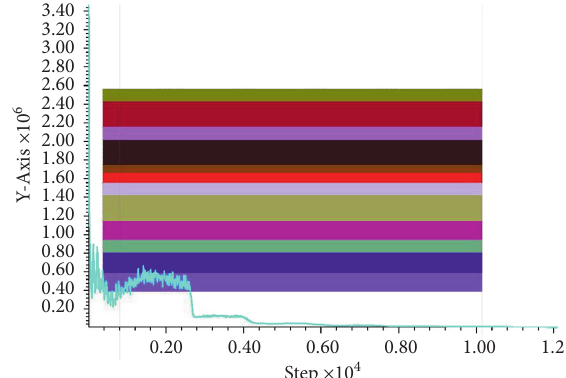
Figure 5: Numerical calculation model in the equilibrium state.